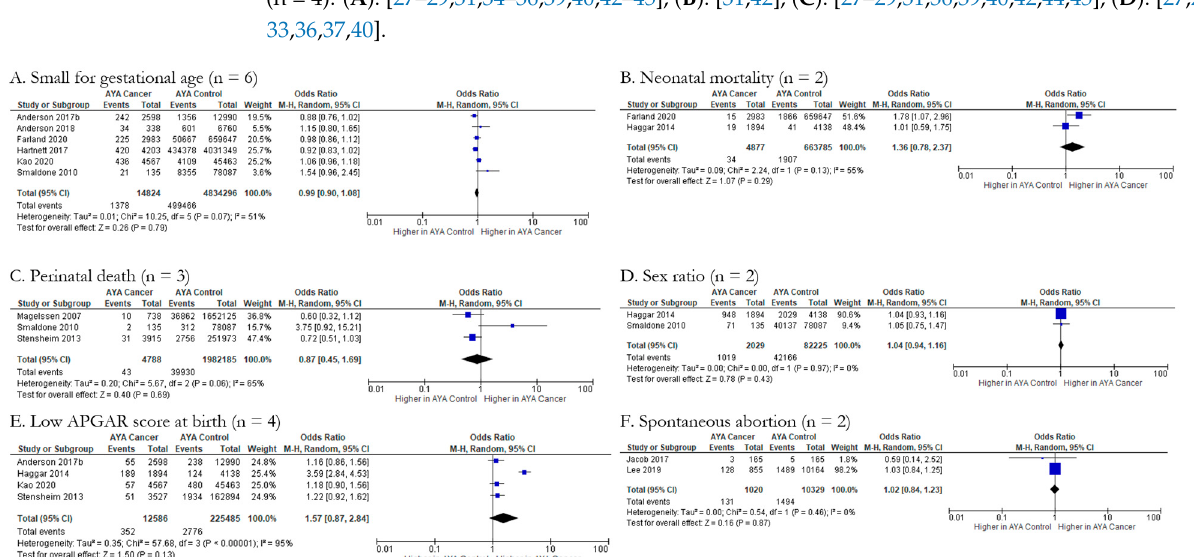
Figure 4. Forest plots for non-significant fetal/neonatal outcomes reported by two or more studies (n = 6). ( A ). [27,39,40,42,44,45], ( B ). [36,44], ( C ). [29,31,40], ( D ). [36,40], ( E ). [27,31,36,42], ( F ). [34,35].